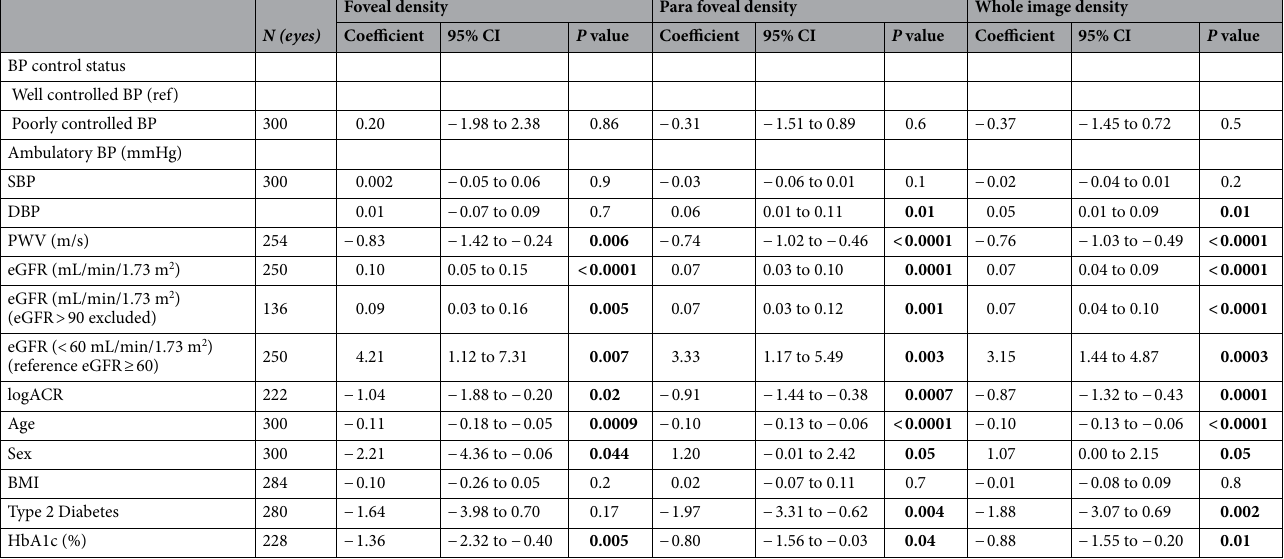
Table 2. Univariate model results. BP, blood pressure; SBP systolic blood pressure; DBP, diastolic blood pressure; N, number of eyes included in the model; CI, confidence interval; PWV, carotid-femoral